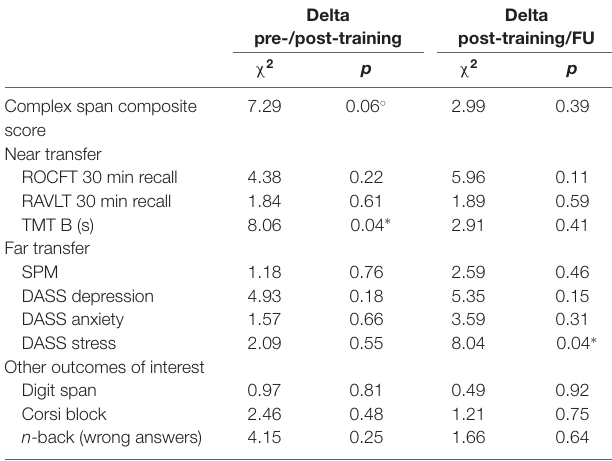
TABLE 5 | Group × session interaction effects of the linear mixed model for all WM and near and far transfer measures with MB + training as a priori contrast.